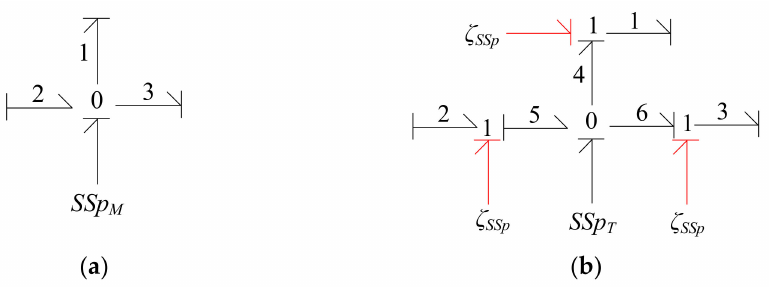
Figure 11. Uncertainty model of pressure sensor measurement: ( a ) not considered; ( b ) considered.